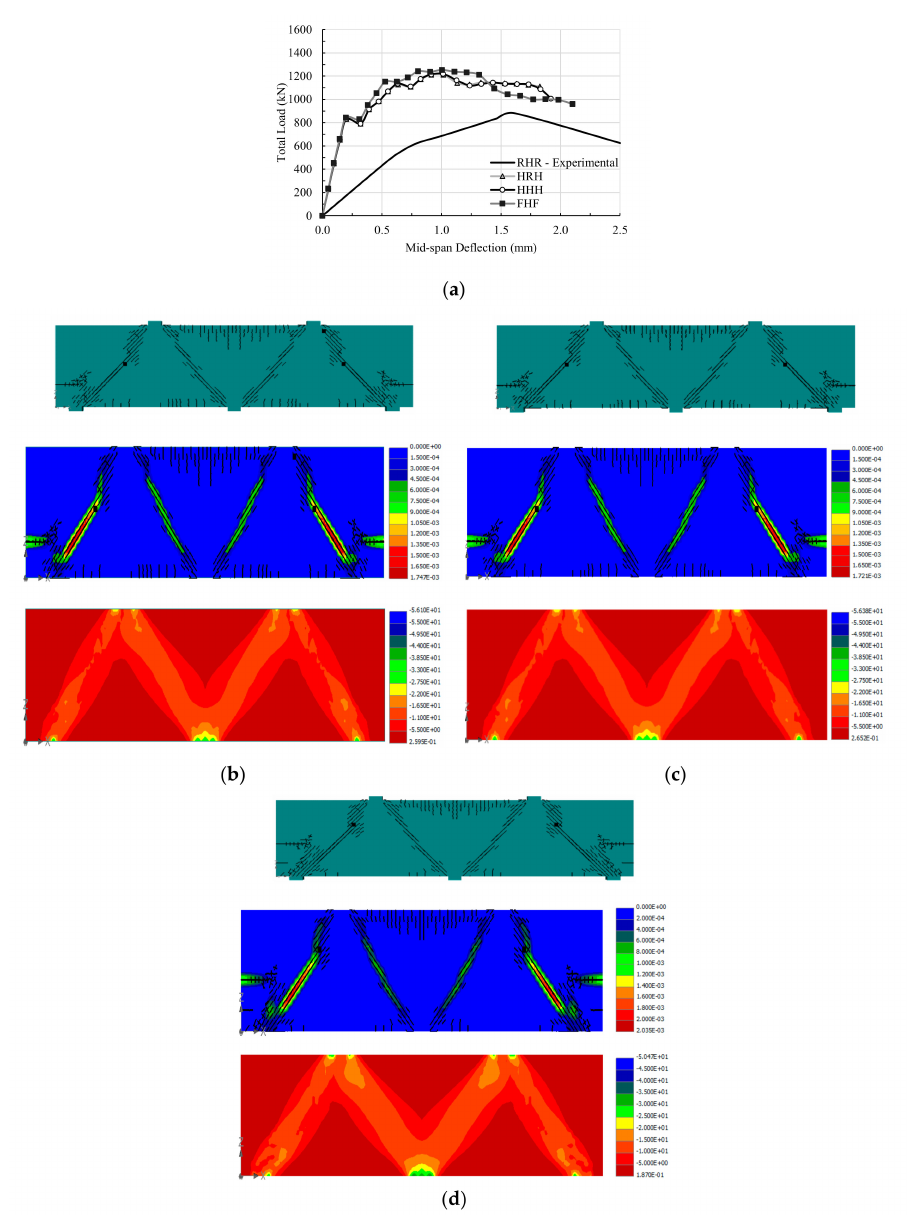
Figure10. ResponsesofspecimenL10-60withthreedi ff erentsetsofsupportconditions: ( a )Experimental (RHR,[9])andnumericalLoad-deflectioncurvesforspecimenL10-60; ( b )crackpattern( top ), crackwidth ( middle ), and stress distribution (MPa) ( bottom )—HRH support conditions; ( c ) crack pattern ( top ), crack width ( middle ), and stress distribution (MPa) ( bottom )—HHH support conditions; ( d ) crack pattern ( top ), crack width ( middle ), and stress distribution (MPa) ( bottom )—FHF support